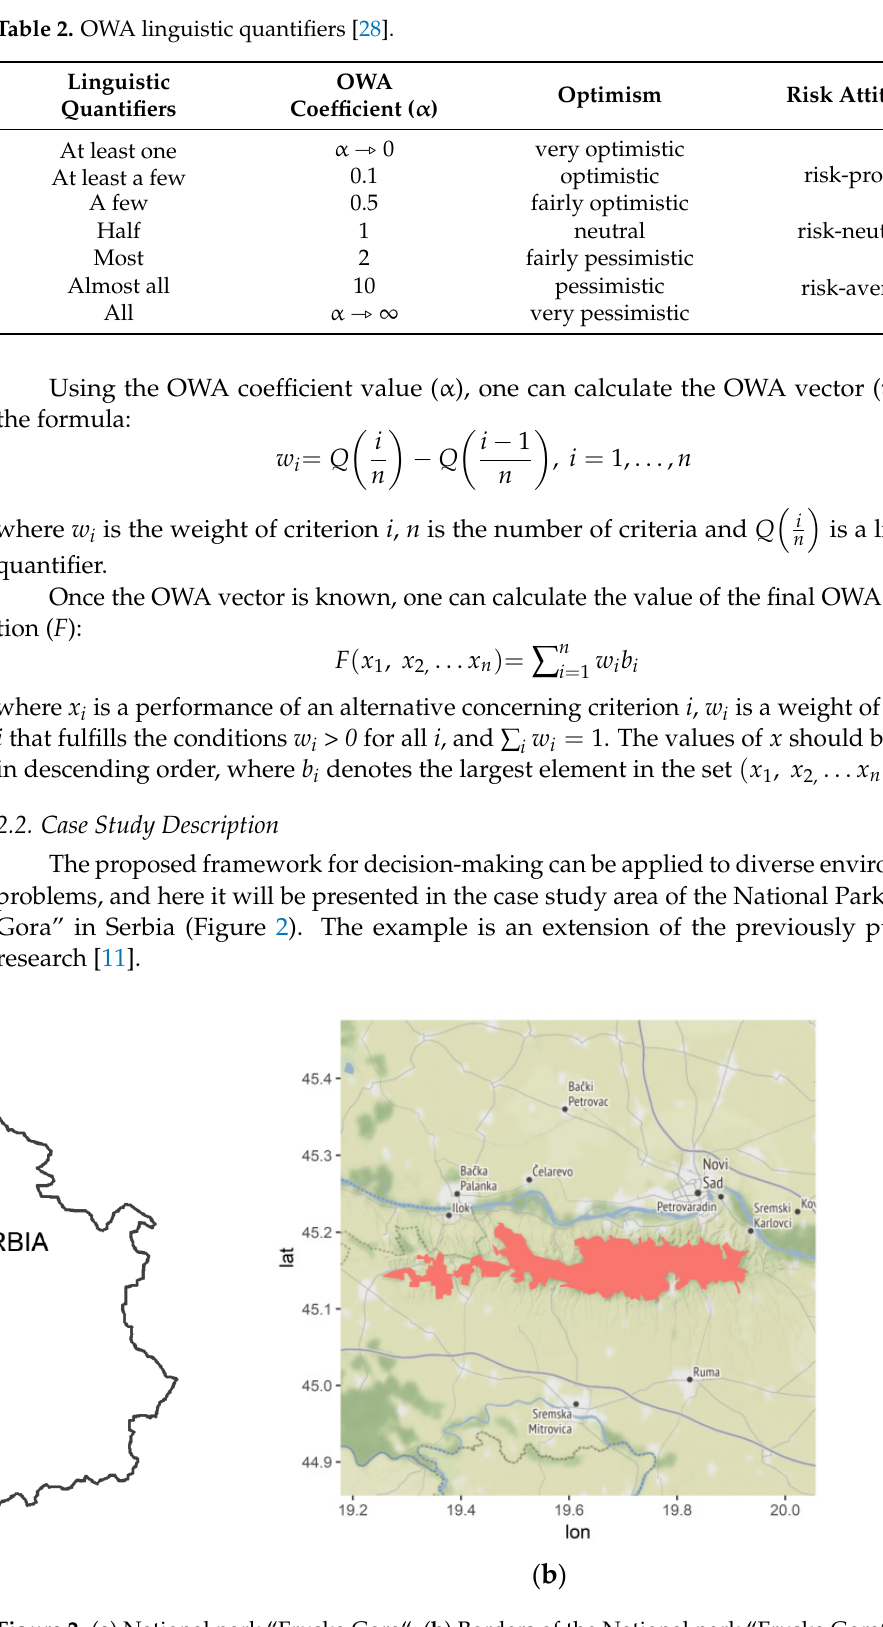
Figure 2. ( a ) National park “Fruska Gora“; ( b ) Borders of the National park “Fruska Gora“. The National Park “Fruska Gora” occupies approximately 255 km 2 , and this is a hilly area with the highest peak of 539 m. It was proclaimed a national park in 1960 and is one